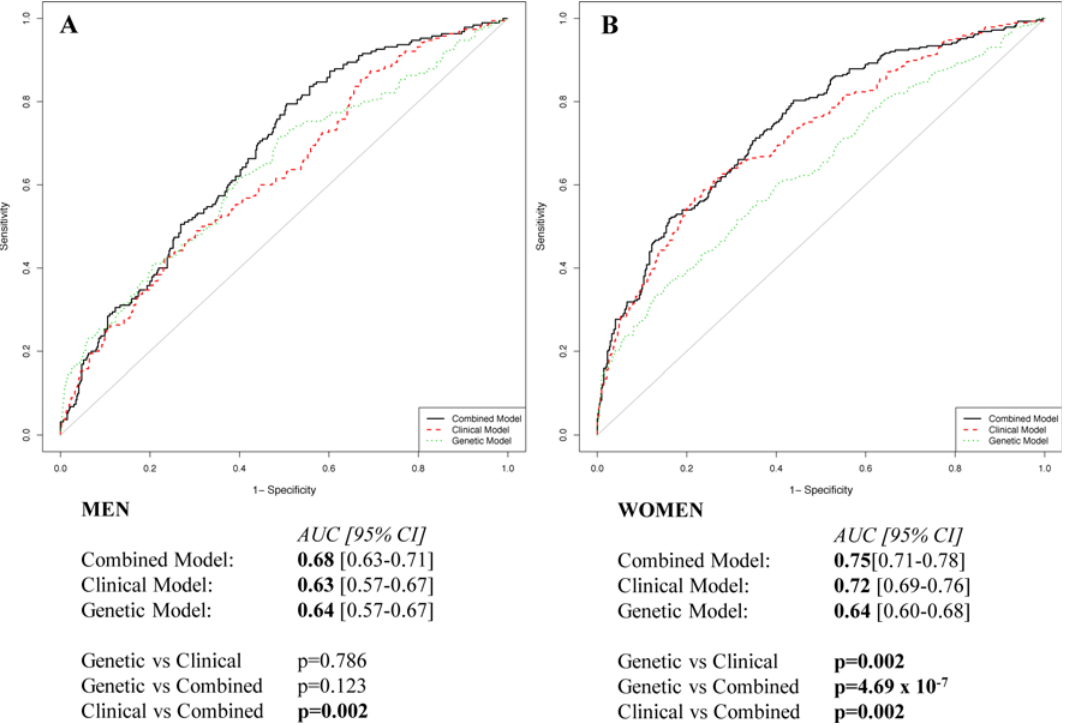
Fig 4. Receiver operating characteristic curve for association with venous thromboembolism in men (A) and women (B). Variables included in the models: Genetic = KIV-2 repeats; Clinical = age, hypertension, smoking habit, dyslipidemia, diabetes, BMI and hyperhomocysteinemia for men, and age, hypertension, smoking habit, dyslipidemia, diabetes, BMI, hyperhomocysteinemia, and oral contraceptives/HRT for women; Combined = Genetic + Clinical variables.